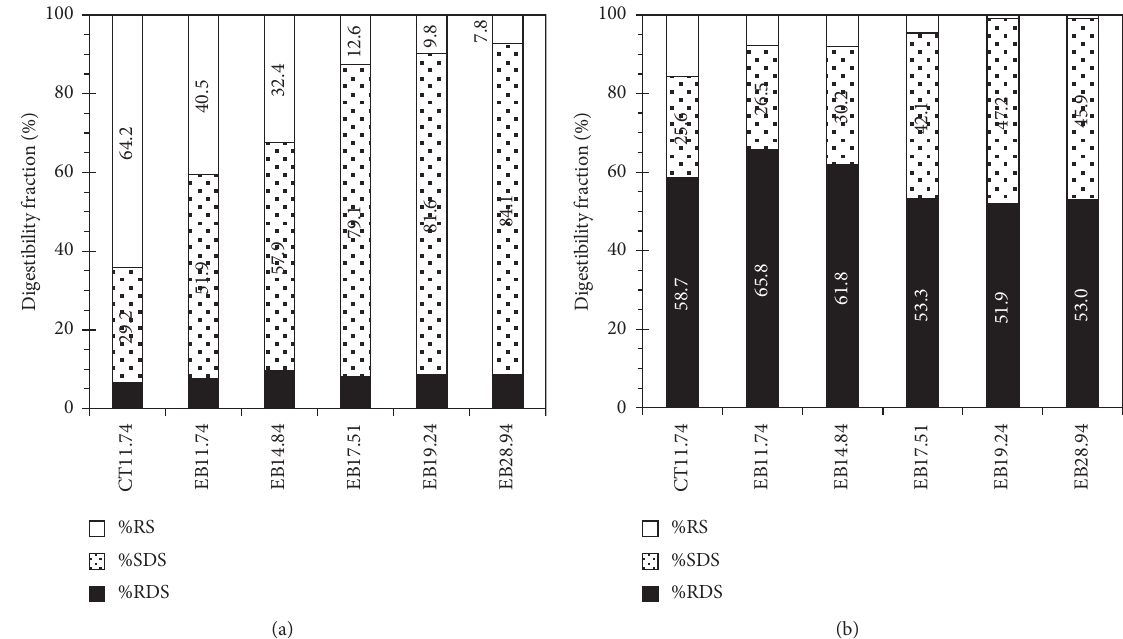
Figure 4: In vitro digestibility of (a) ungelatinized and (b) gelatinized starches.